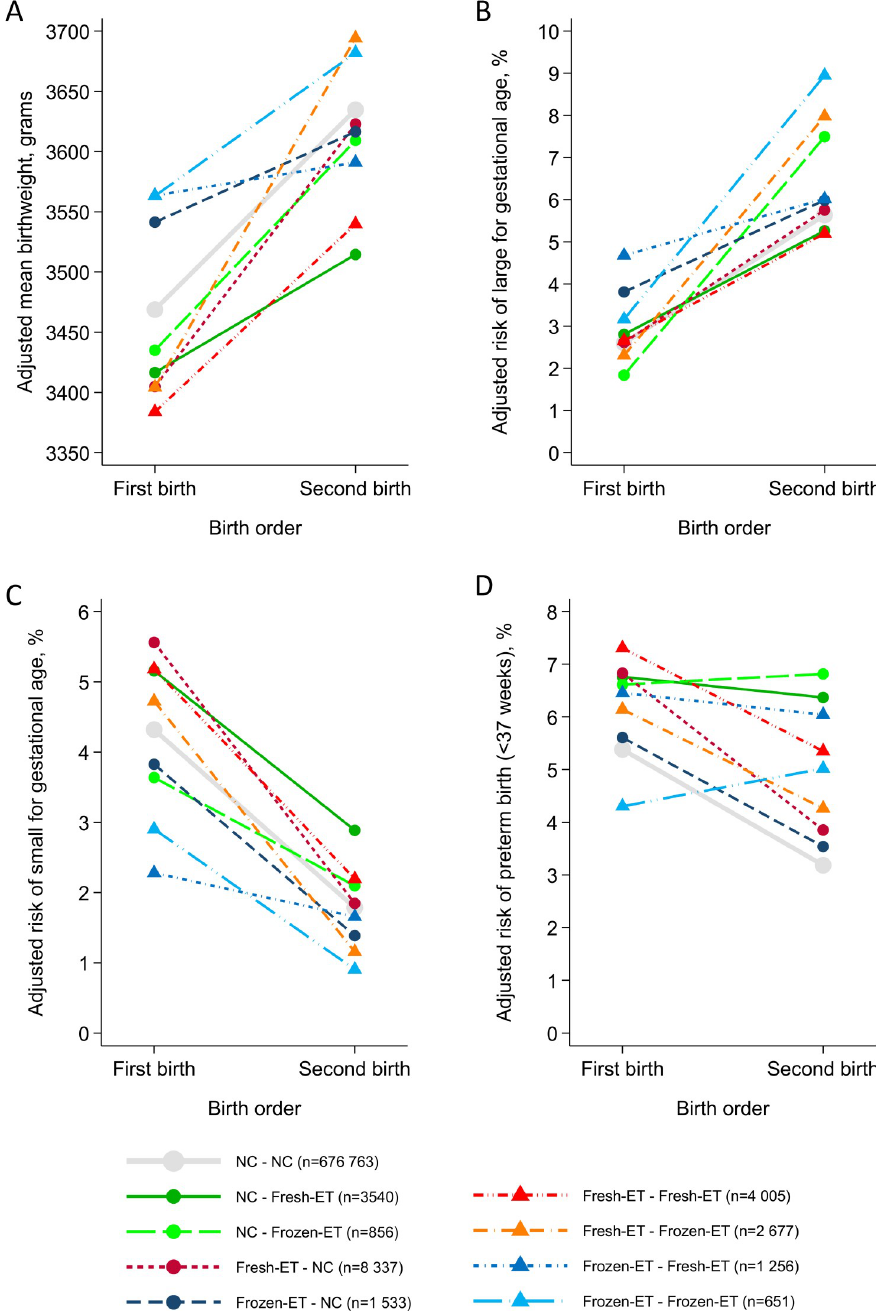
Fig 3. Perinatal outcomes in consecutive offspring sibling pairs according to birth order and conception methods. AU : InFig 3 C ð y (cid:0) axislabel Þ : gestationalismisspelled : Pleasefix : Whileyouareinthere ; Irecommendunhyphenatingsmallforgestationalageandlargeforgestationalage ; tomatchthemaintext : Means and absolute risks are estimated in main sample 2, using random effects logistic models with post-estimation commands. Adjusted for maternal age, offspring birth year, country, maternal body mass index, smoking status, and height. Fresh-ET, fresh embryo transfer; Frozen-ET, frozen embryo transfer; NC, natural conception.